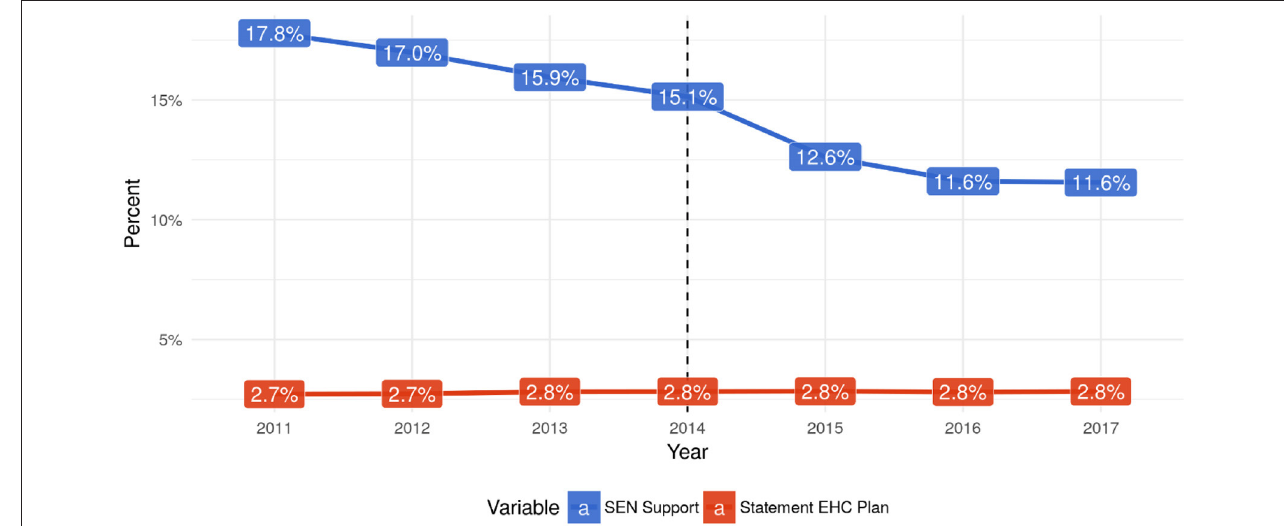
FIGURE 5 | The proportion of school children with SEN support and EHCP/Statement in England, 2011–2017.